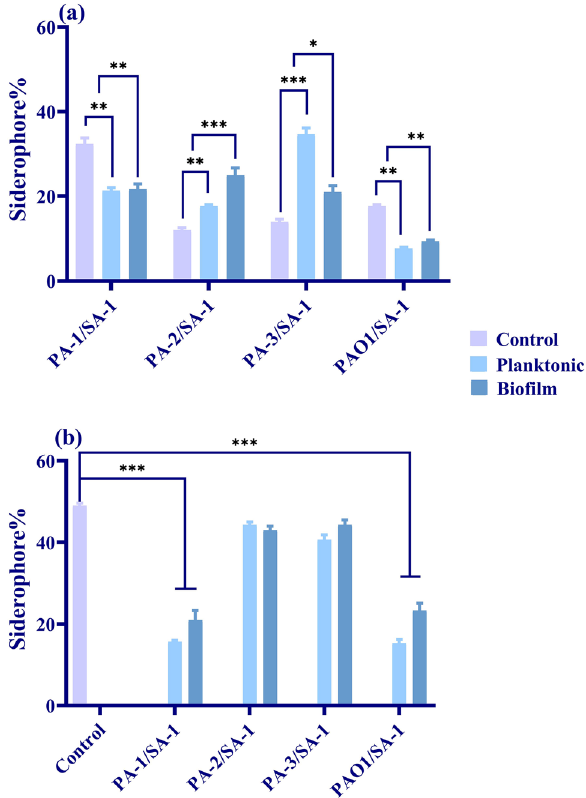
Figure 5. Siderophore production ( a ) P. aeruginosa and ( b ) S. aureus in the monoculture, the planktonic and biofilm states of co-culture. Each data set was analyzed using the student’s t-test, and the Holm-Sidak